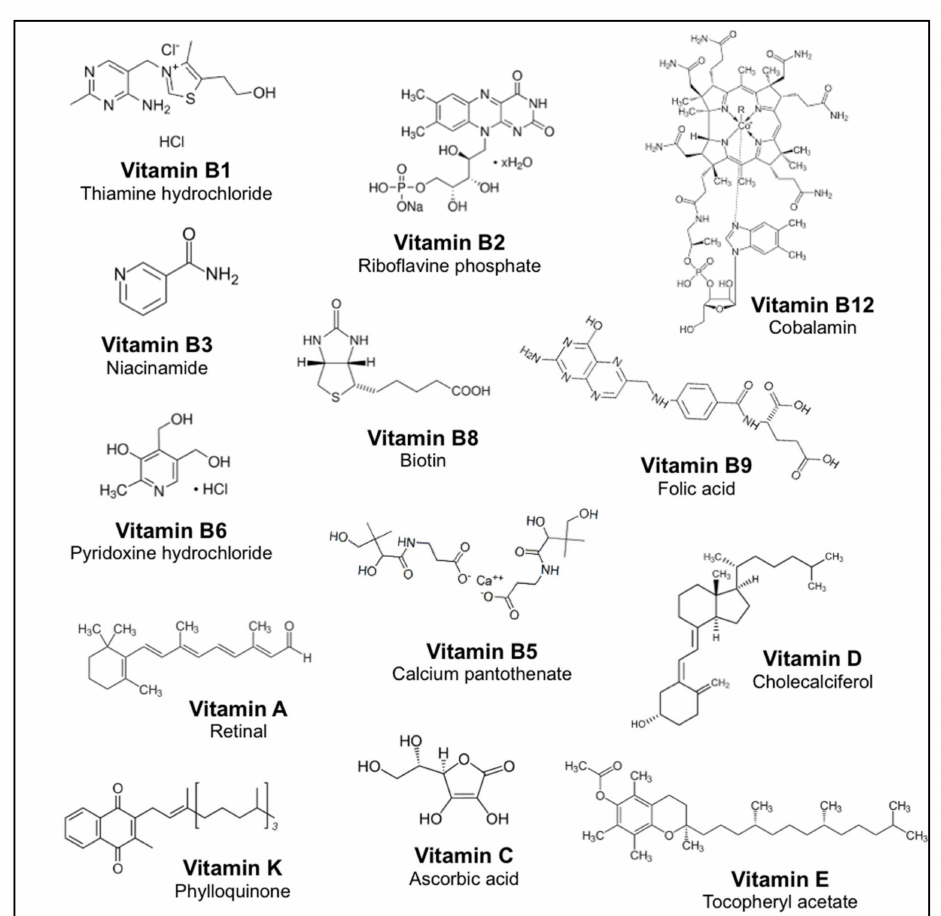
Figure 1. Chemical structure of the thirteen vitamins